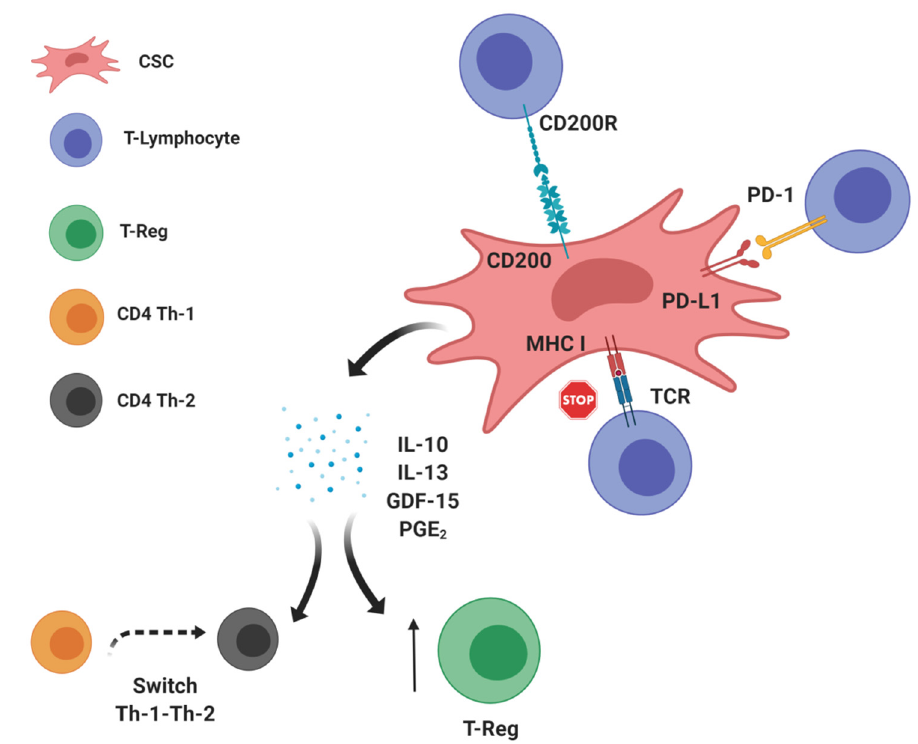
Figure 1. Schematic representing the core findings described in Section Altered expression of molecules involved in ag presentation (MHC I), the activity of immune cells (CD200 and PD-L1), and the release of immunomodulatory molecules with protumorigenic effects (IL-10, IL-13, GDF-15, and PGE 2 ) by CSCs. Created by Biorender.